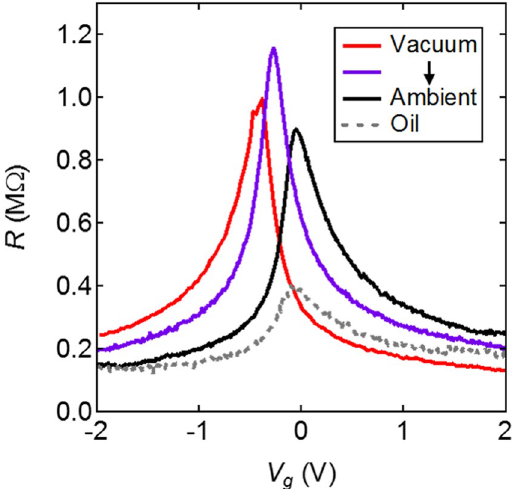
Figure 3. The resistance of a narrow-gap CNT measured with different band alignment conditions (red, purple and black curves) and the same CNT measured in refractive index oil (dashed gray curve). Further analysis of this device (Device #4) appears in Fig.